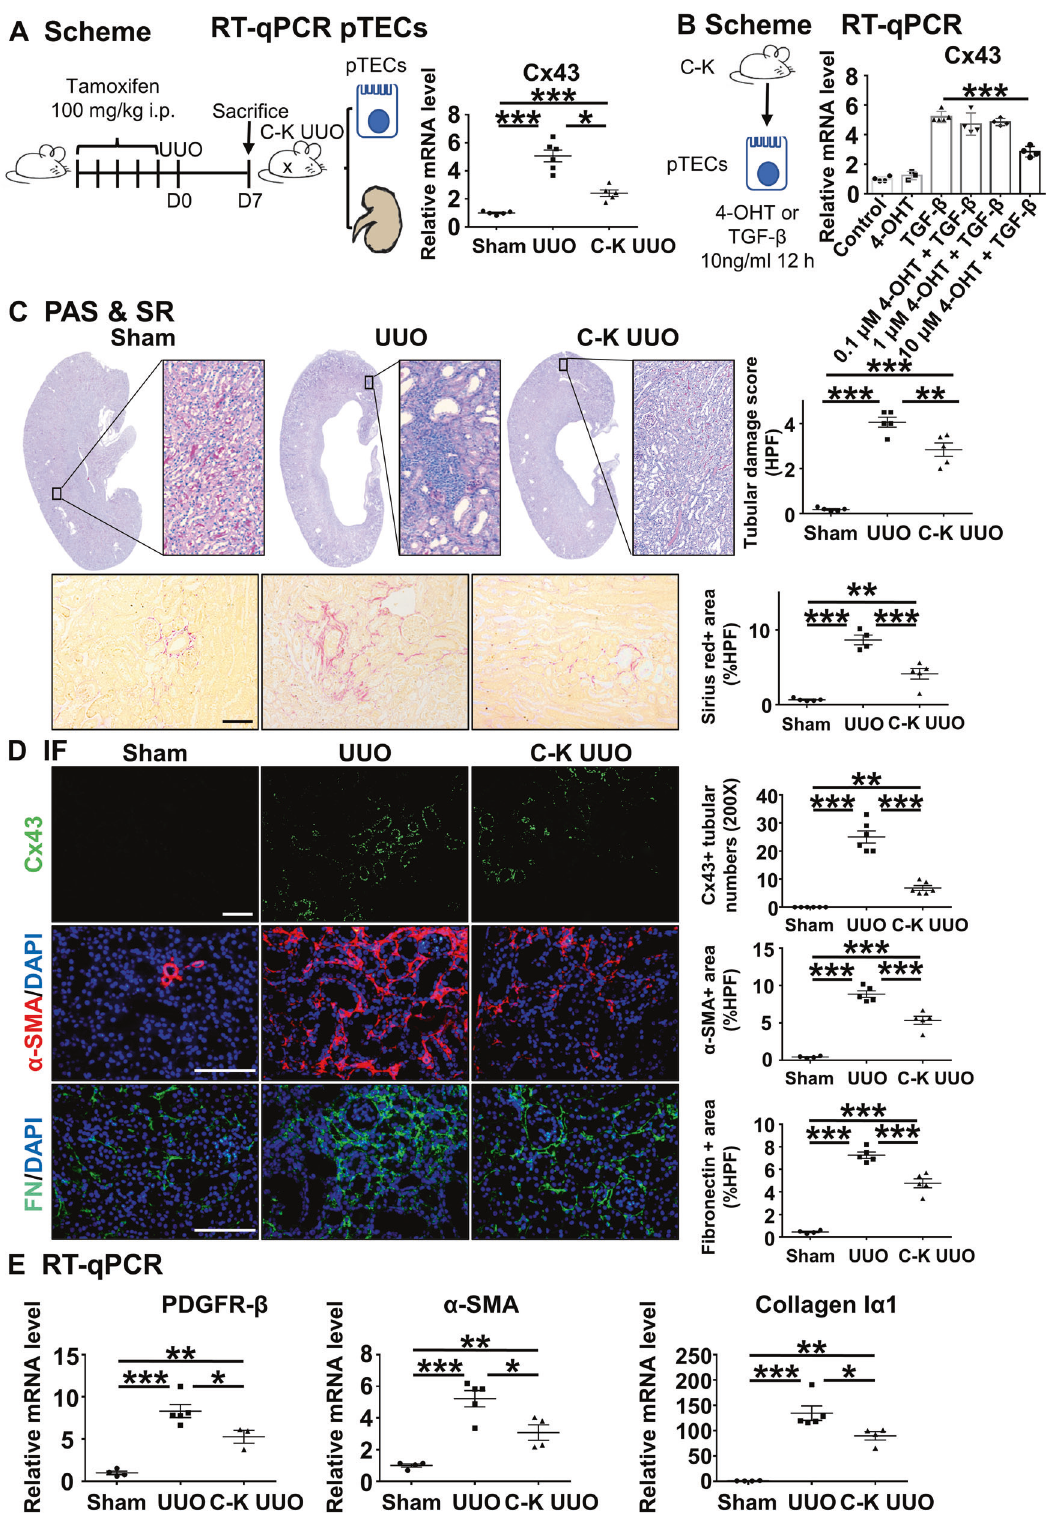
Fig. 3 Knockout the Cx43 gene of TECs prevents UUO-induced renal injury and RIF. A , B Experiment schematic and Levels of mRNA encoding Cx43 by RT-qPCR. C PAS staining was performed to evaluate renal tubular injury by calculating damaged tubules with dilation swelling or epithelial cell brush border loss. The red area in SR staining indicates extracellular fi brotic collagen deposition in renal interstitium. D Immuno fl uorescence. Representative photomicrographs for immuno fl uorescence labeled Cx43 (green), α -SMA (red), and FN (green). Corresponding graphs indicate the expression of Cx43 (green), α -SMA (red) and FN (green). E RT-qPCR. Levels of mRNA encoding α -SMA, Fibronectin, Collagen I α 1 by RT-qPCR. Data are presented as the mean ± SEM, n = 3 – 6/group, * P < 0.05, ** P < 0.01, *** P < 0.001; Scale bar: 100 μ m.